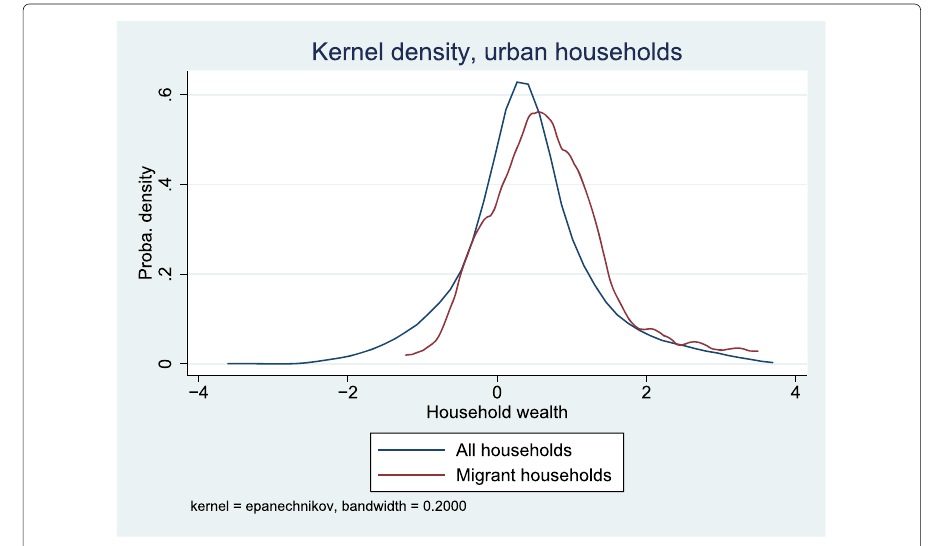
Fig. 3 Household wealth and migration: urban households